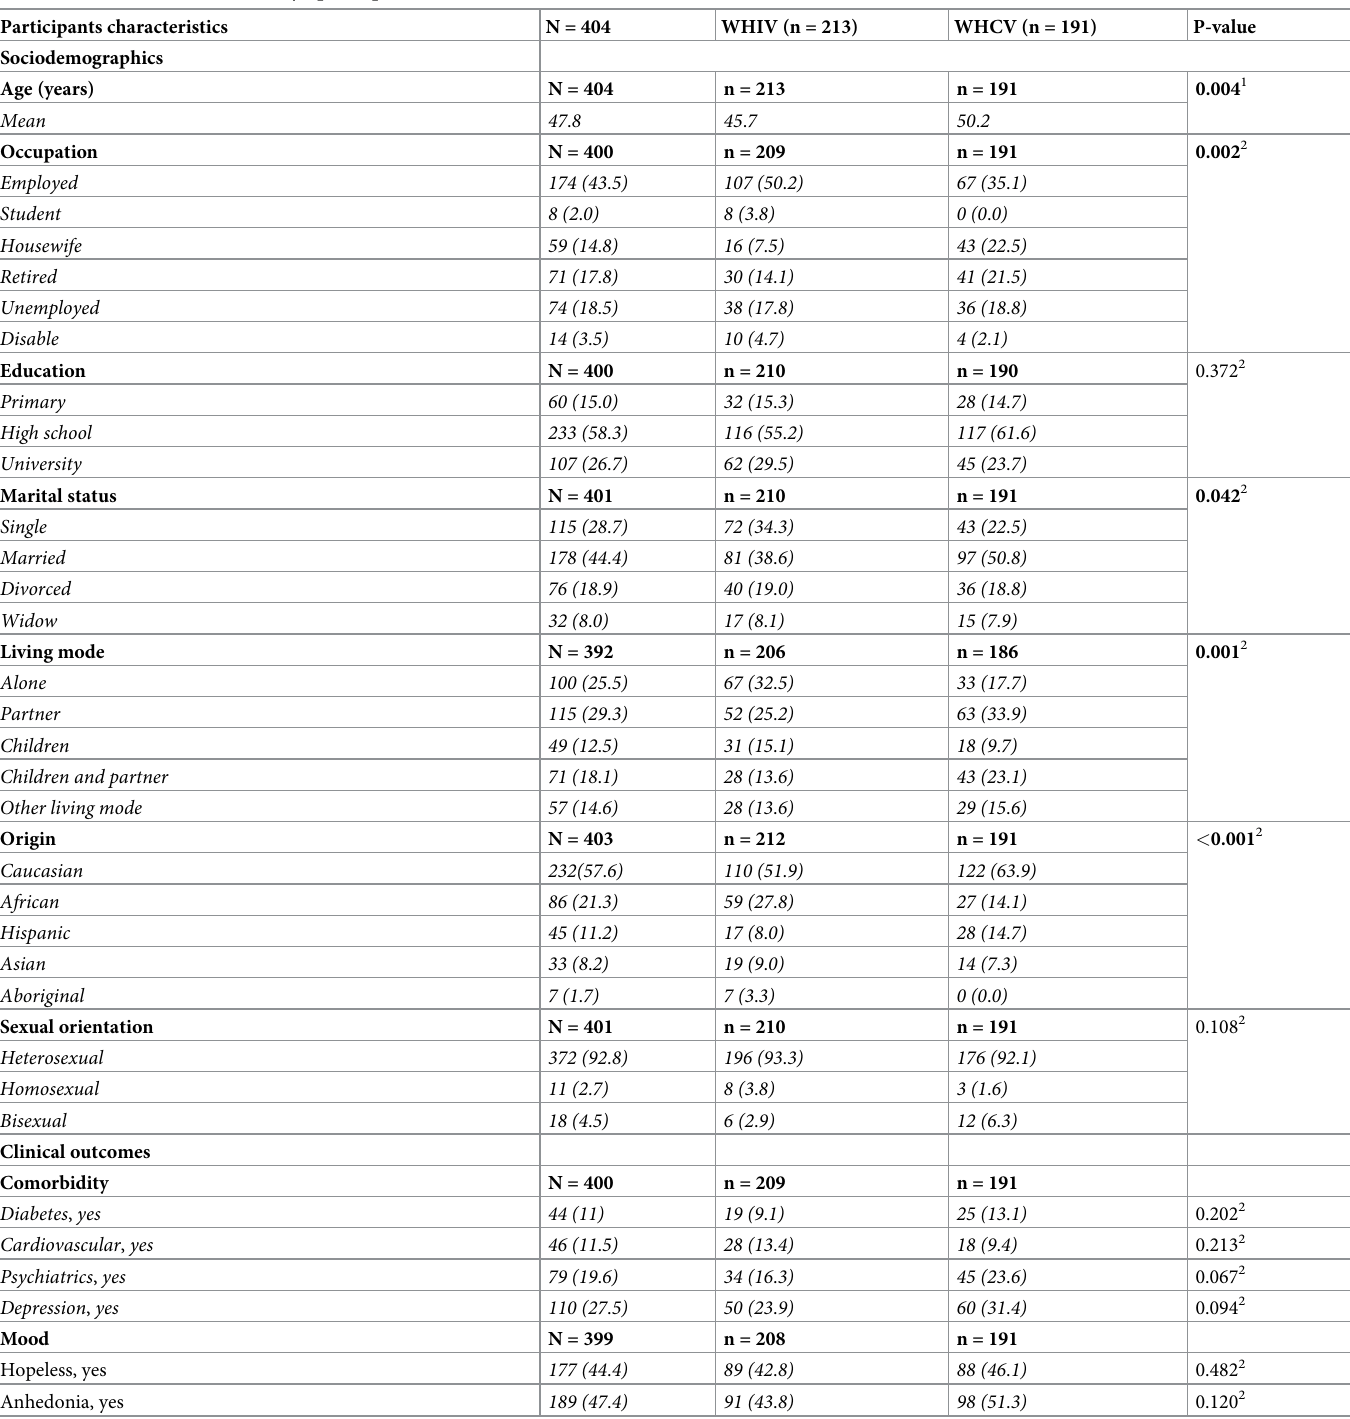
Table 1. Characteristics of the study’s participants (N =